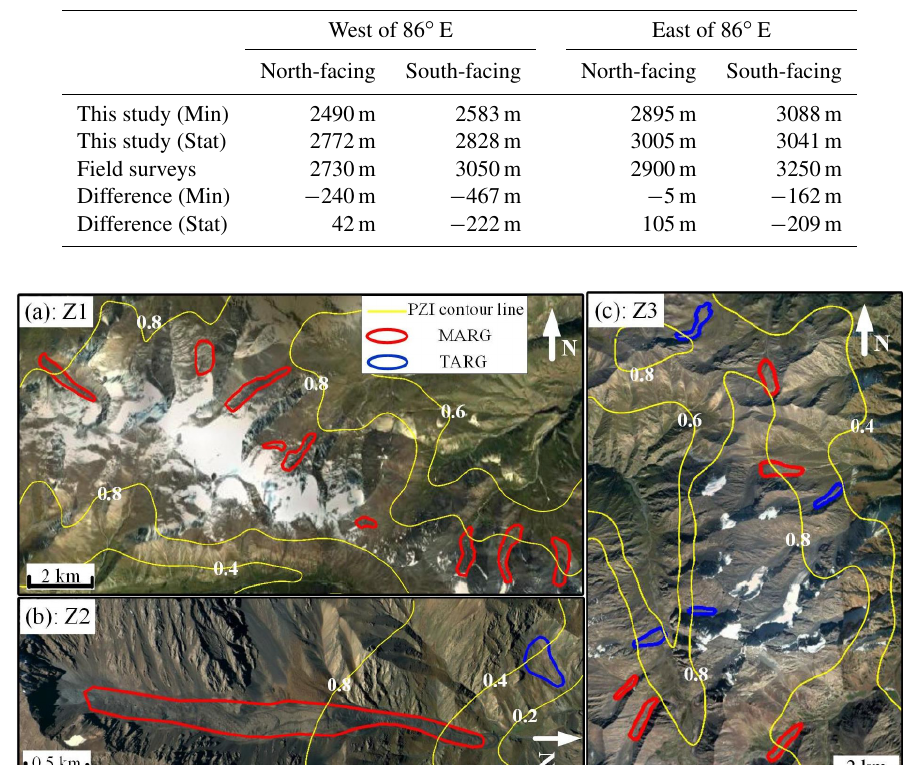
Table 3. The lower altitudinal limits of permafrost distribution in the NTS inferred from this study using the inventoried TARGs. “This study (Min)” denotes the altitudinal limits inferred from specific TARGs with the lowest FLP altitudes. “This study (Stat)” denotes the altitudinal limits inferred from the statistics-based calculations of FLP altitudes. The limits from “Field surveys” are based on the work of Qiu et al. (1983). The rows “Difference (Min)” and “Difference (Stat)” list the differences between the results inferred from this study and the field surveys, respectively. All the altitudes given by this study are derived from the SRTM digital elevation model data with an uncertainty of about 16m.